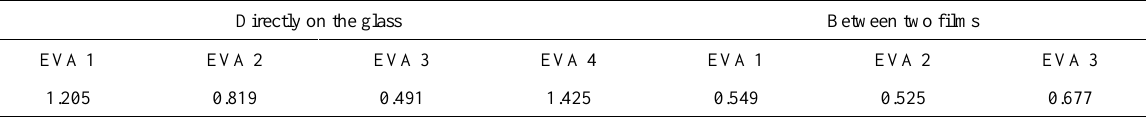
Table 4: Average shear modulus of the samples with sprayed paint (MPa) Directly on the glass Between two films